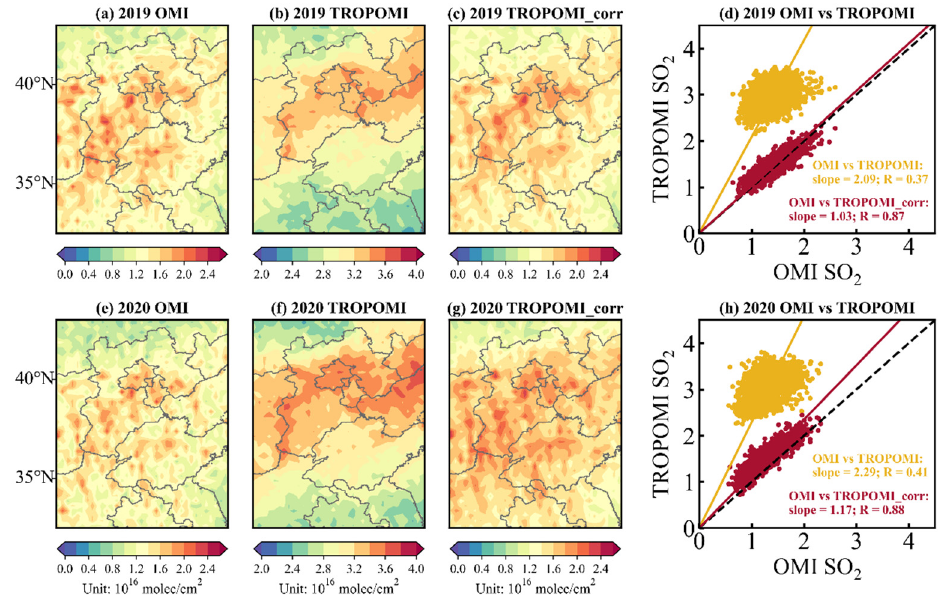
Figure 9. Comparisons of annual SO 2 VCDs over NCP from OMI and TROPOMI. SO 2 VCDs derived from OMI and TROPOMI in 2019 and 2020 are shown in panels ( a , b , e , f ), respectively, along with the corrected TROPOMI shown in panels ( c , g ). Scatter plots of TROPOMI SO 2 vs. OMI SO 2 and corrected TROPOMI SO 2 vs. OMI SO 2 in 2019 and 2020 are shown in panels ( d , h ), respectively.